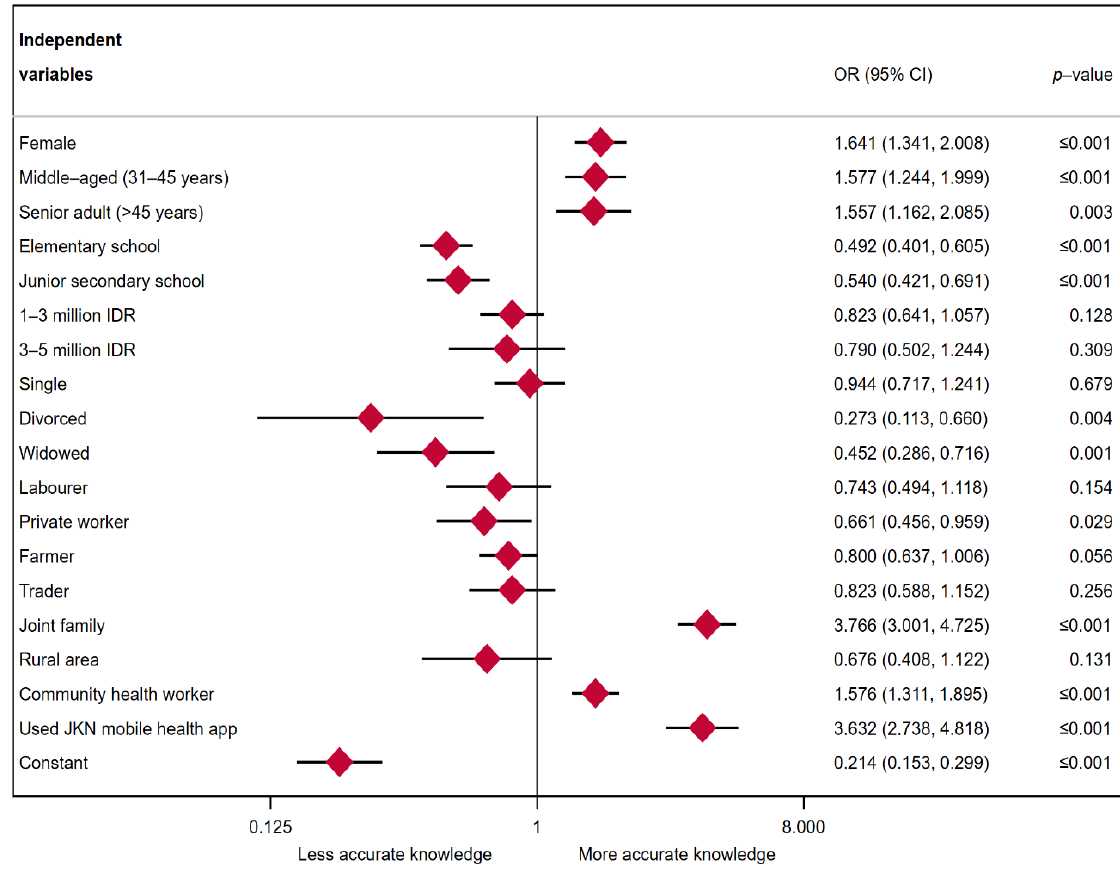
Figure 1. Multiple logistic regression results: knowledge about COVID-19.